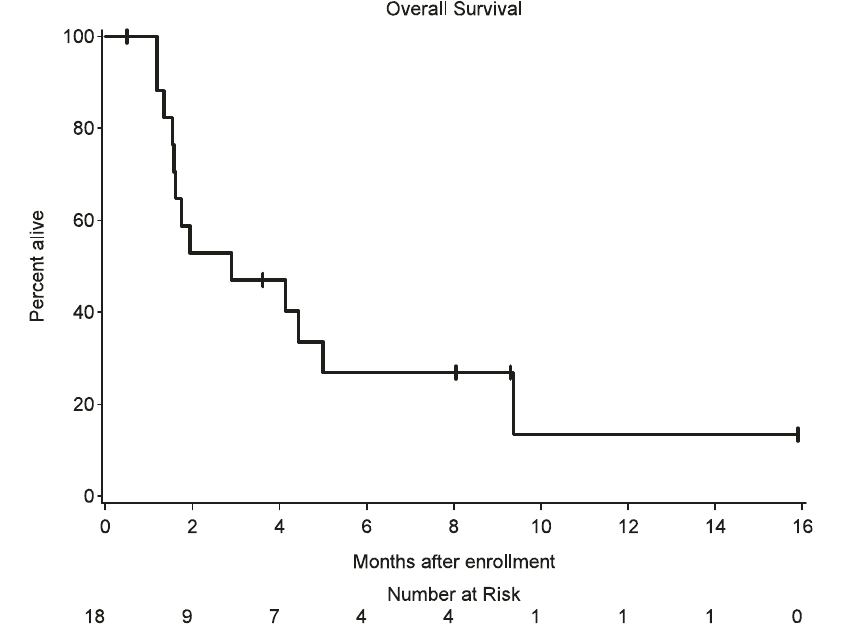
Fig. 1 Overall survival in 18 patients with LMD from solid tumors. Median overall survival was 2.9 months (90% CI: 1.6 – 5.0 months).